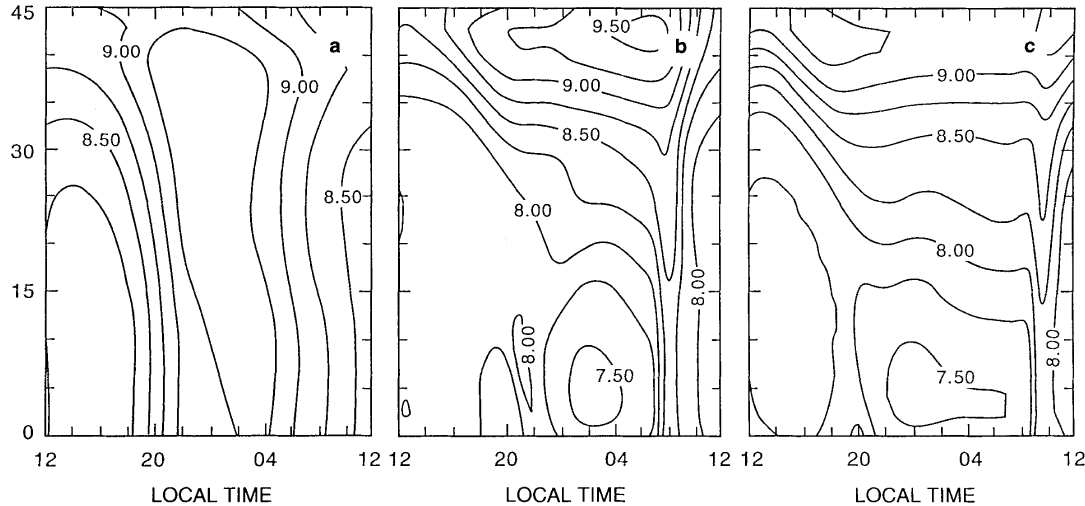
Fig. 8a–c. Latitude versus local time contours of log